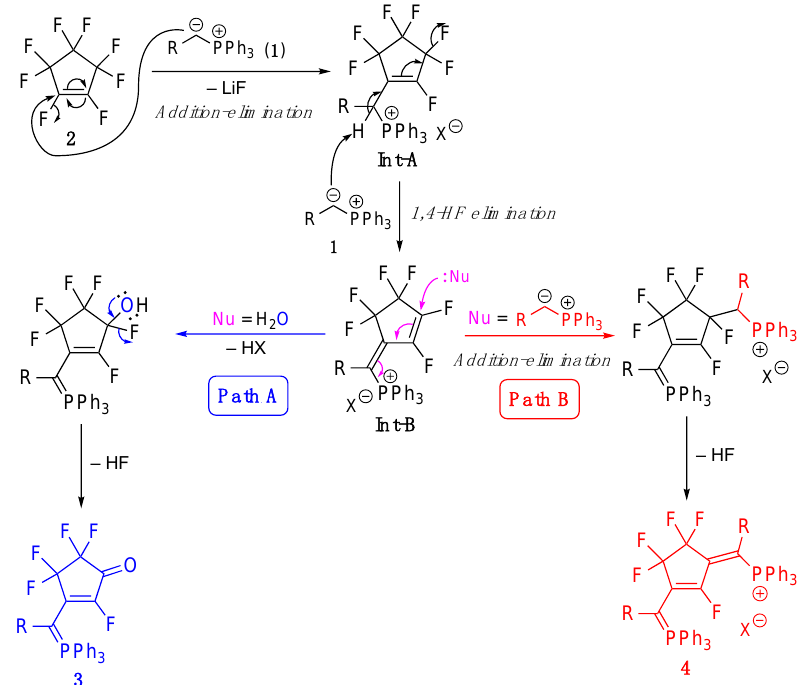
Figure 3. The proposed reaction mechanisms for the synthesis of fluorinated merophosphinines 3 and phosphinines 4 .